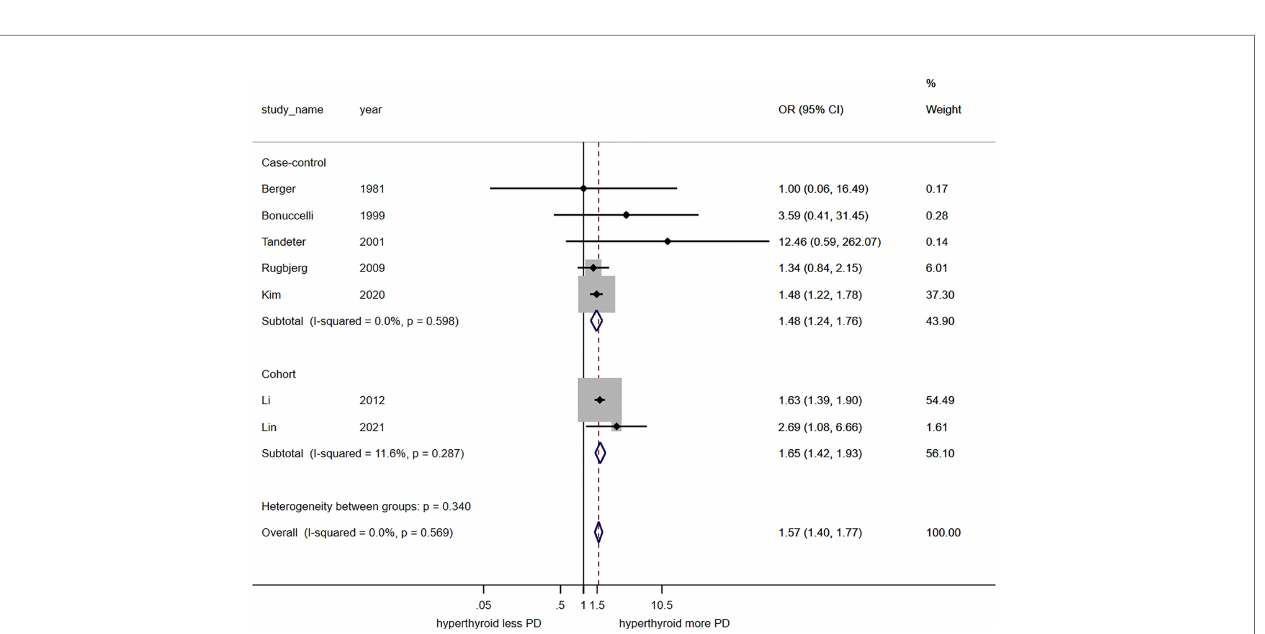
FIGURE 3 | Forest plot of the meta-analysis of risk of Parkinson ’ s disease in patients with hyperthyroidism.